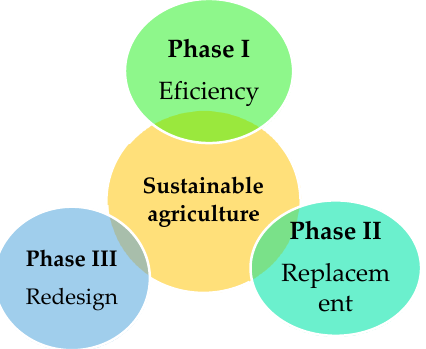
Figure 1. Transactional phases for sustainability in the agricultural environment.